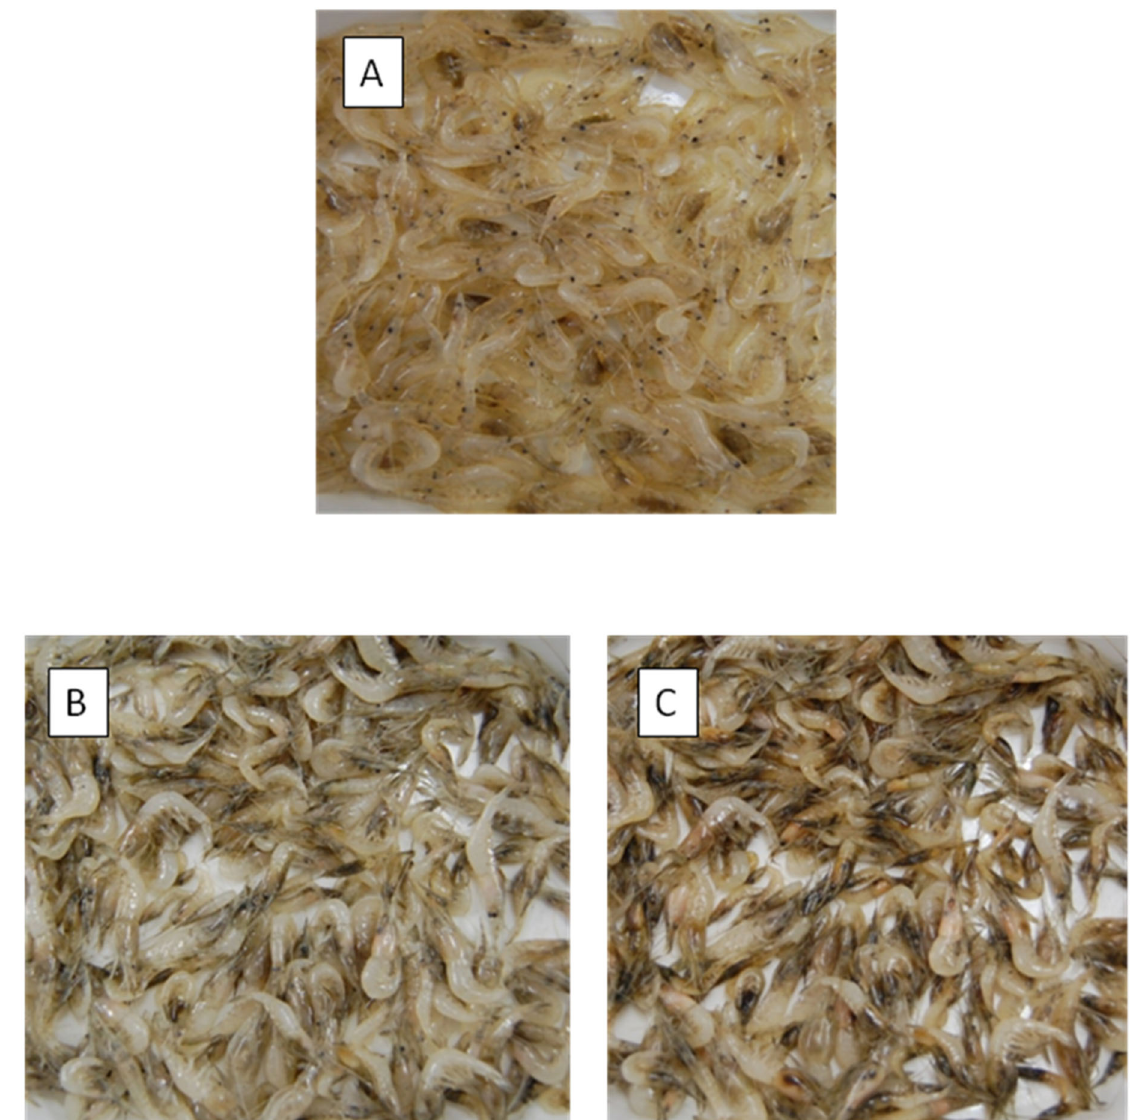
Figure 2. Atlantic ditch shrimp treated for 10 min with 10 μ M of diselenide of bis ‐ HT. ( A ) shrimp before the treatment, ( B ) treated shrimp after 5 days of refrigerated storage at 4–6 °C, ( C ) untreated shrimp after 5 days of refrigerated storage at 4–6 °C.